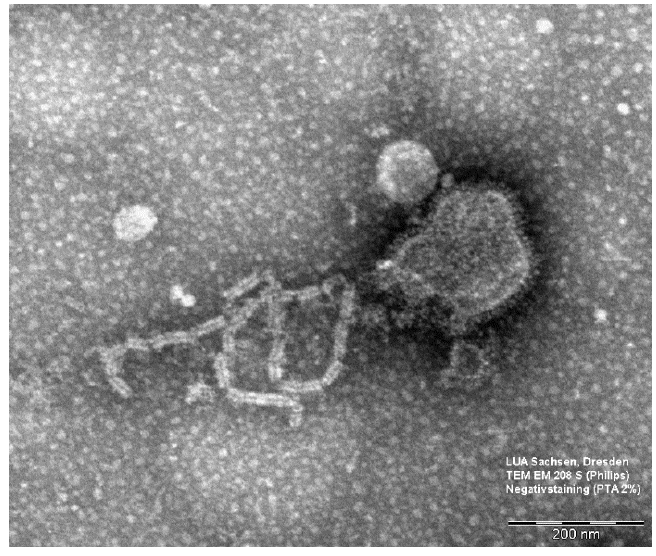
Figure 2. Electron micrograph of Giant squirrel respirovirus (GSqRV) with liberated ribonucleoprotein complex.